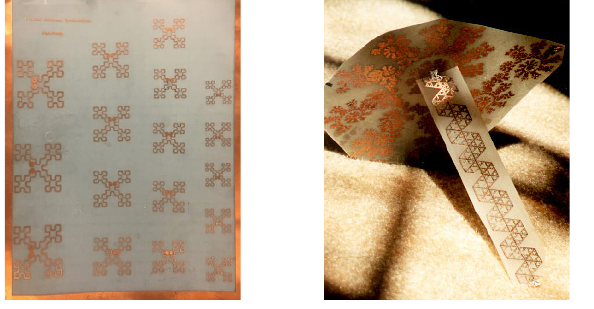
Figure 26. The first manufactured fractal antenna sheets (1995). Image source: https://www. fractenna.com/, accessed on 22 June